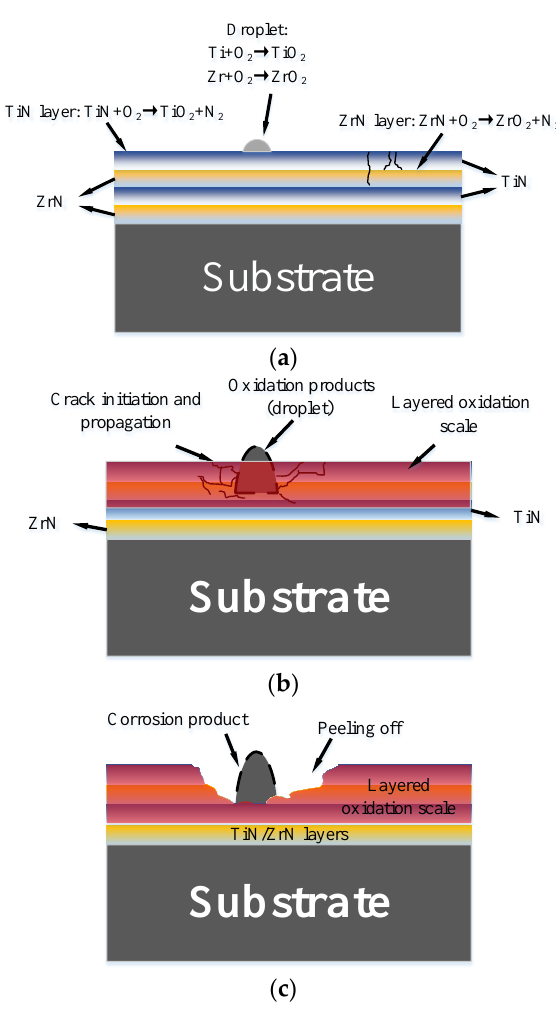
Figure 21. Schematic diagram of the corrosion process of TiN/ZrN coating in hot corrosion environment. ( a ) Oxidation of the surface; ( b ) Layered oxidation and crack propagation; ( c ) Squeezed and peeled off.